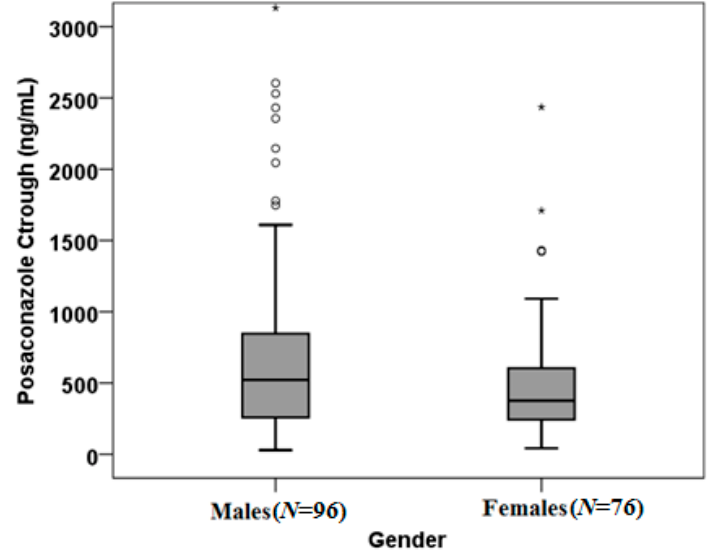
Figure 1. Plots of gender influence on posaconazole trough concentration, considering all the 172 enrolled patients ( p = 0.028). Boxes and black lines in boxes represent respectively interquartile ranges (IQR) and median values; open dots and stars represent outlier values. Median values (horizontal line), interquartile range (IQR, bars), patient values (black square), highest and lowest value (whiskers) are shown. Males ( N = 96) had 521.50 ng/mL (IQR: 256.00–240.25 ng/mL) median concentrations; Females ( N = 76) had 376.50 ng/mL (IQR: 240.25–376.50 ng/mL) median concentrations.